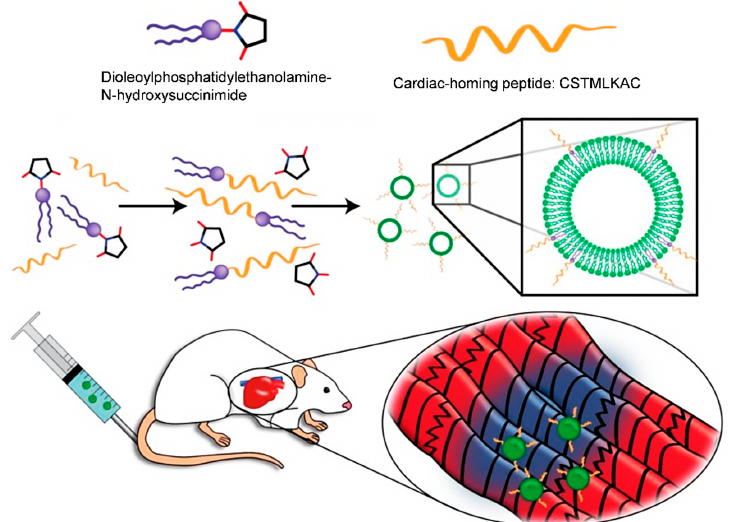
Figure 2. Cardiac-homing exosomes. Myocardium-targeting exosomes were produced by reacting DOPE-NHS to cardiac homing peptide (CHP). Then, the lipophilic tails of the DOPE-CHP sponta- neously insert into the exosomal membrane, coating the exosome in CHP peptide. The exosomes were, then, intravenously injected into rats following I/R injury. Reproduced with permission [146].